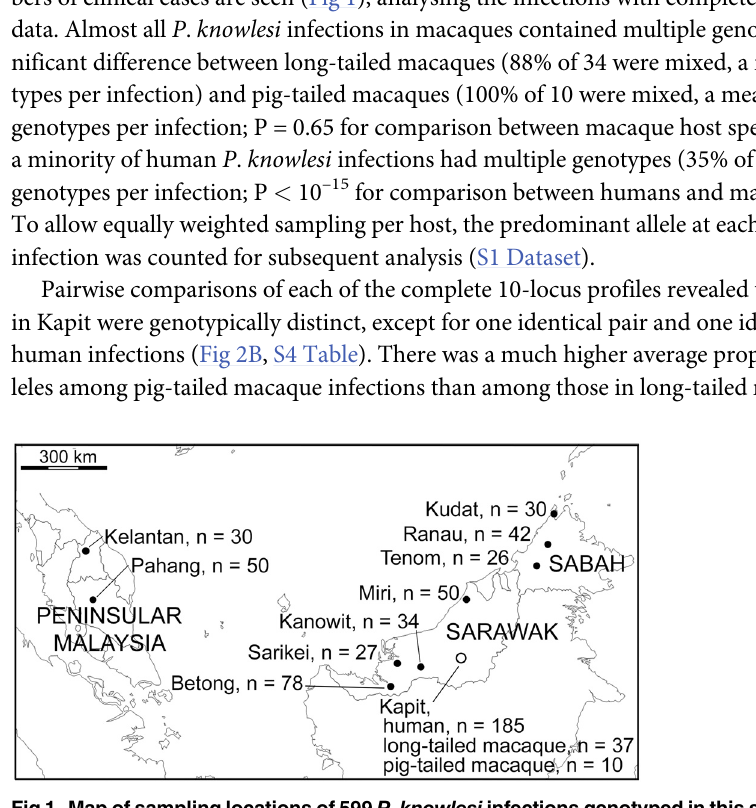
Fig 1. Map of sampling locations of 599 P . knowlesi infections genotyped in this study. A total of 552 samples were from P . knowlesi malaria patients from 10 geographical locations: Peninsular Malaysia (Kelantan and Pahang), Sarawak (Kapit, Betong, Miri, Kanowit and Sarikei), and Sabah (Kudat, Ranau and Tenom). Additionally, 47 samples were from wild macaques (37 long-tailed and 10 pig-tailed macaques) with P . knowlesi infections in